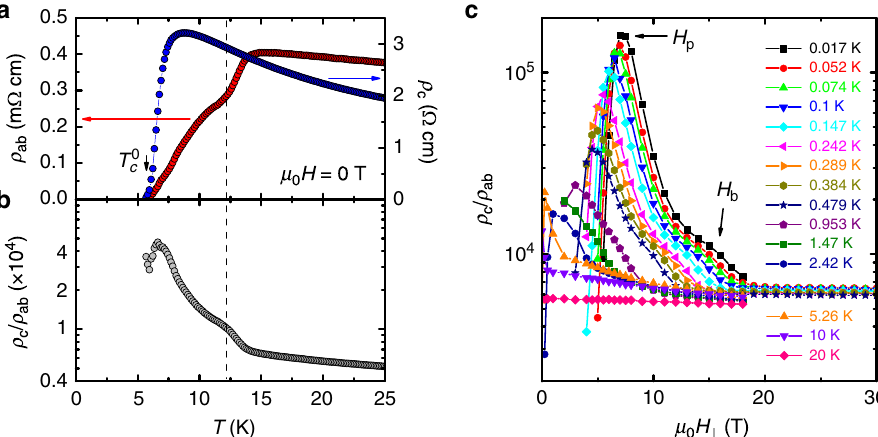
Fig. 1 Evolution of the anisotropy in La 1.7 Eu 0.2 Sr 0.1 CuO 4 with T and H ⊥ . a ρ ab ( T ) and ρ c ( T ), and b the anisotropy ratio ρ c / ρ ab ( T ), in zero fi eld. The vertical dashed line indicates where SC correlations are established in the planes, resulting in the enhancement of the anisotropy; ρ c continues to grow with decreasing T . c ρ c / ρ ab vs. H ⊥ at different T , as shown. Arrows show the positions of the anisotropy peak H p , or the decoupling fi eld, as well as H b , where the anisotropy is enhanced. The method to determine H b more precisely is described in Supplementary Fig.